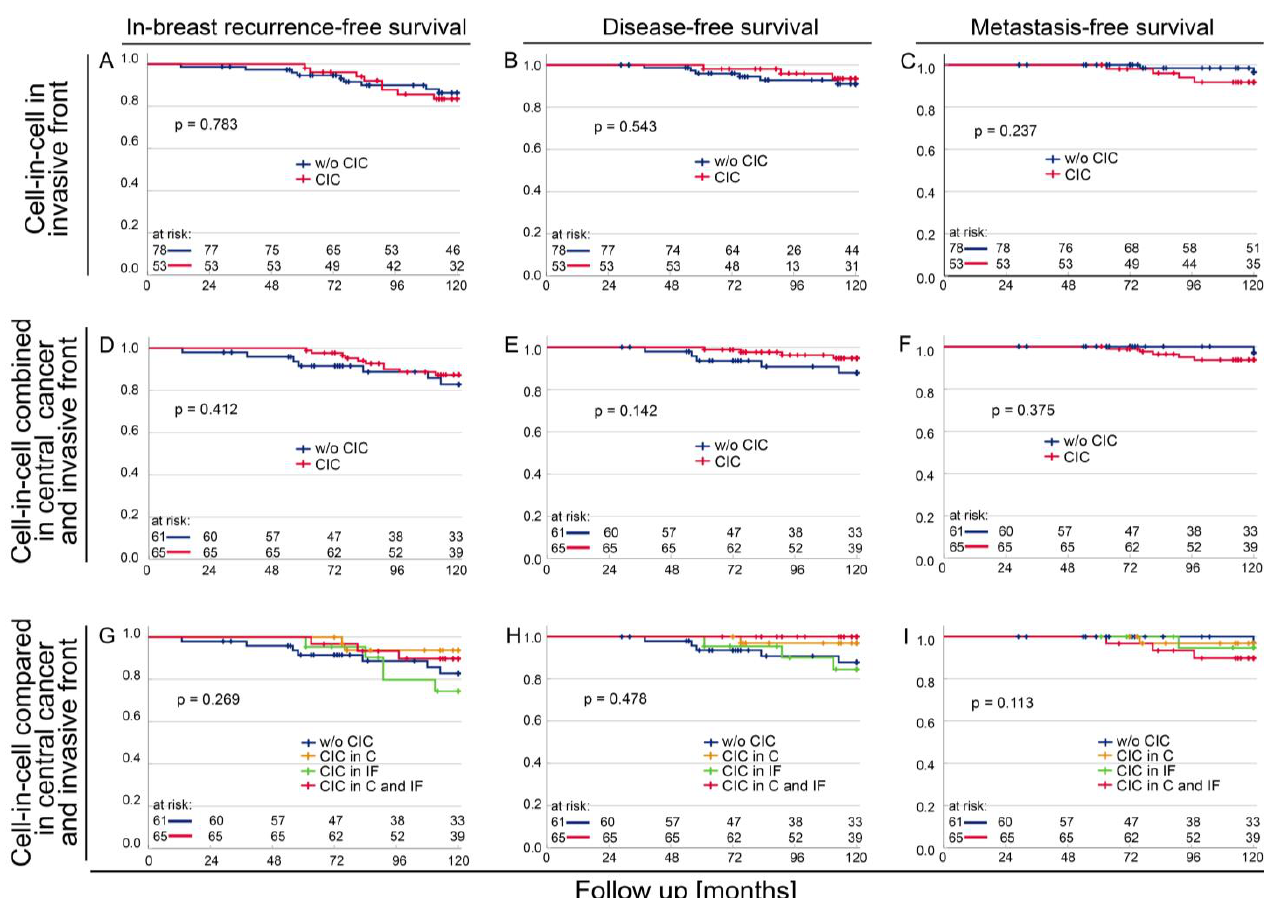
Figure 5. Kaplan – Meier plots depending on cell-in-cell (CIC) origin. Patients with tissue without CICs and patients with tissue and CICs were compared and Kaplan – Meier plots were calculated for ( A ) Local recurrence free survival, ( B ) Disease-free survival, and ( C ) Metastasis-free survival. CIC combined in central cancer and invasive front were determined and Kaplan – Meier plots were calculated for ( D ) Local recurrence free survival, ( E ) Disease-free survival, and ( F ) Metastasis-free survival. CIC in central cancer and invasive front or central cancer or invasive front without CIC were compared and Kaplan – Meier plots were calculated for ( G ) Local recurrence free survival, ( H ) Disease-free survival, and ( I ) Metastasis-free survival of the total cohort.